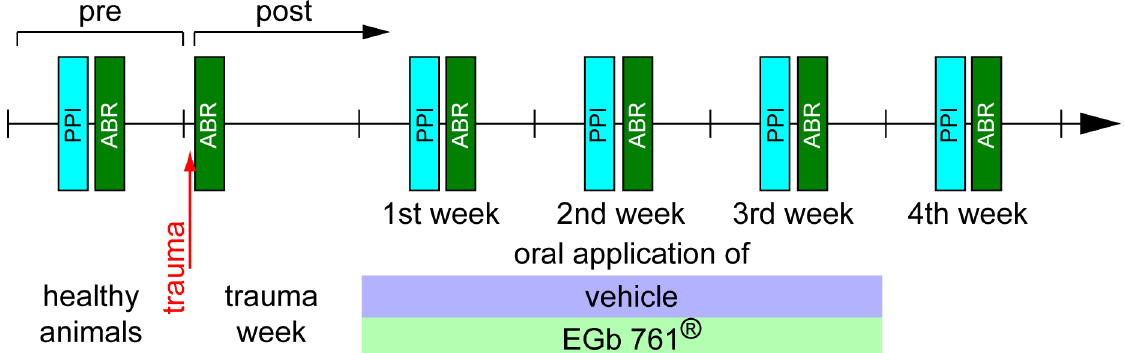
Fig 1. Experimental protocol. PPI of the ASR was always measured ahead of ABR measurements. The trauma consisted of a 2 kHz pure tone, presented for 75 min at 115 dB SPL. Animals were either treated with vehicle (2% Agar in water) or EGb 761 1 (100mg/kg in 2% Agar in